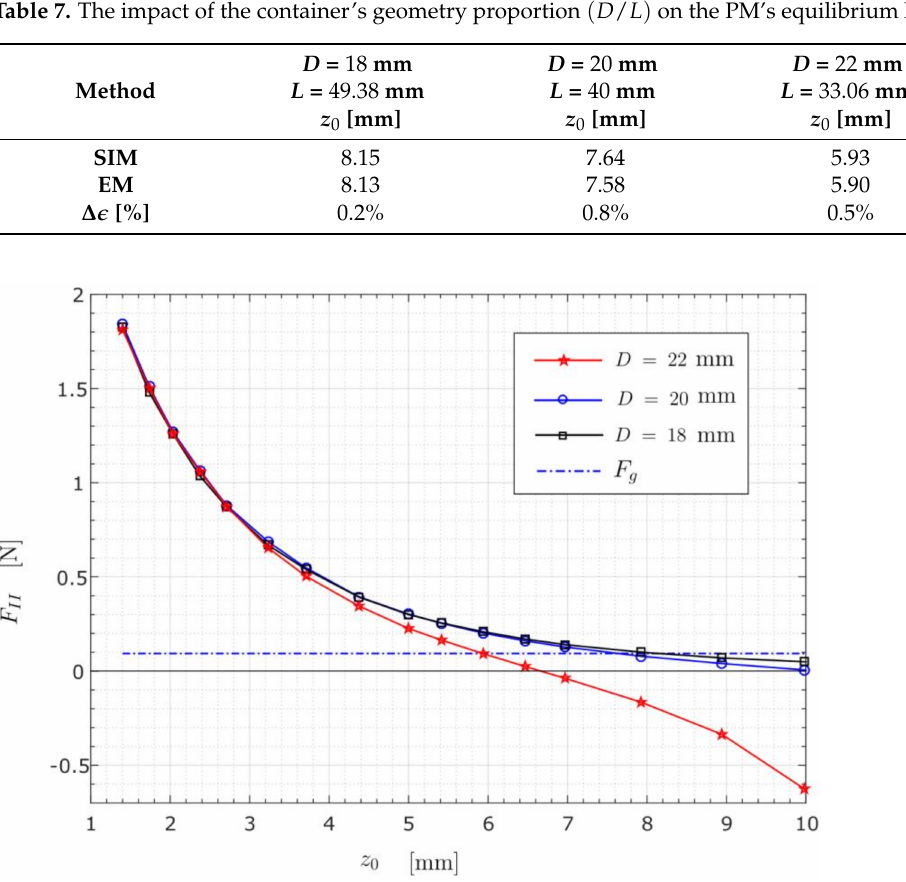
Figure 22. The calculated curves of magnetic levitation force F II for three different values of container diameter, i.e., D = 18 mm, D = 20 mm, and D = 22 mm, respectively. The force F II was calculated by the SIM. The stable levitation height z 0 appears where the individual curve F II in-tersects the gravitational force line F g . In the calculations the container’s volume re-mained